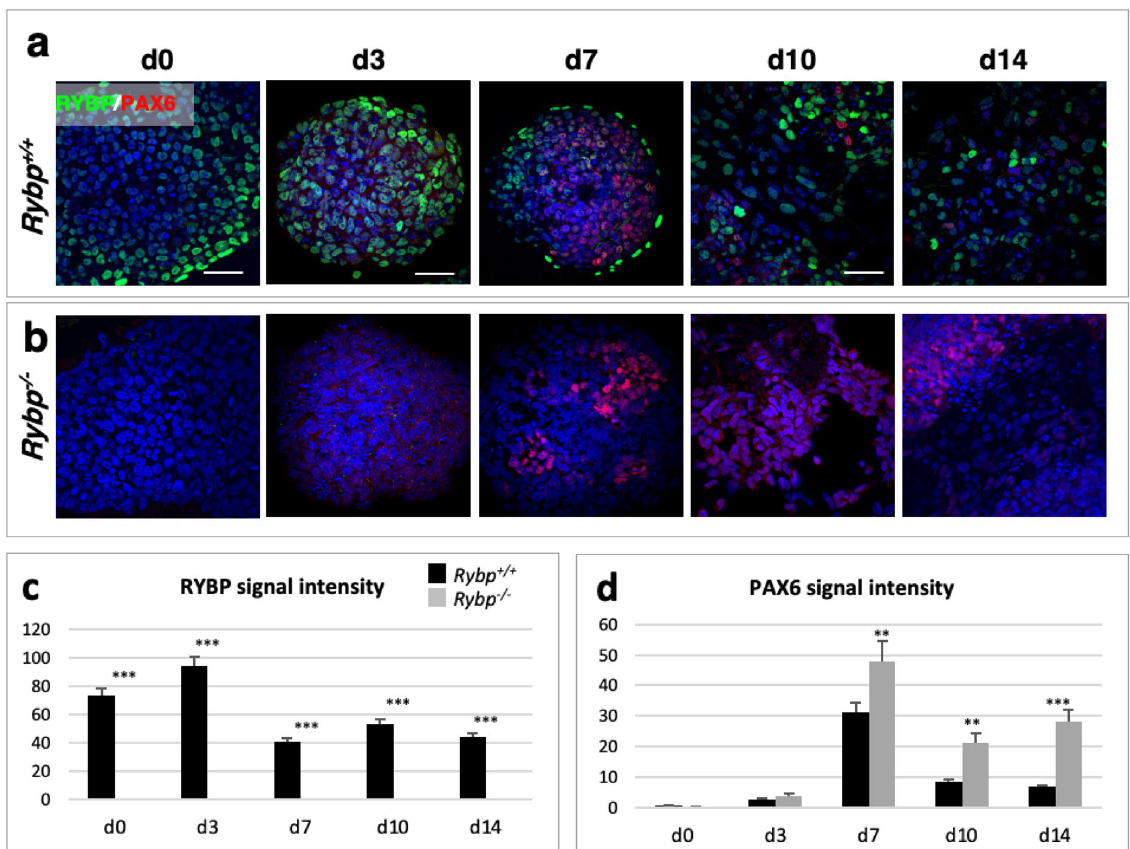
Figure 4. Immunocytochemical localization of RYBP and PAX6. Immunocytochemical analysis of RYBP and PAX6 protein level in ( a ) Rybp + / + and ( b ) Rybp −/− cells during in vitro neural differentiation. Objective: d0, d10 and d14: 60x; d3 and d7: 40x. Scale bar: d0, d10 and d14: 100 μm; d3 and d7: 80 μm. ( c , d ) ImageJ quantification of ( c ) RYBP and ( d ) PAX6 protein level in the wild type and Rybp −/− cells during in vitro neural differentiation. Means are standard deviation ± SD. Values of p < 0.05 were accepted as significant (* p < 0.05; ** p < 0.01; *** p < 0.001). Statistical method: t test type 3, n = methods, Immunocytochemistry (ICC)) to compare the PAX6 protein level in the wild type and the Rybp −/− lines (Fig. 3c,d). PAX6 protein was detected as early as d3 both in the wild type and the Rybp −/− EBs at a very low level (Fig. 3a,b). As expected, at later time points (d7, d10 and d14) the staining intensity of PAX6 was stronger in the atRA treated EBs (Fig. 3b–d) compared to the untreated EBs (Fig. 3a,c,d) in both cell lines. Results were further confirmed by quantification of the PAX6 protein signals by ImageJ (Fig. 3c,d). These results showed that even without atRA treatment PAX6 was present in an excess in the absence of Rybp in comparison to the wild type EBs, and this difference was more pronounced after atRA treatment.